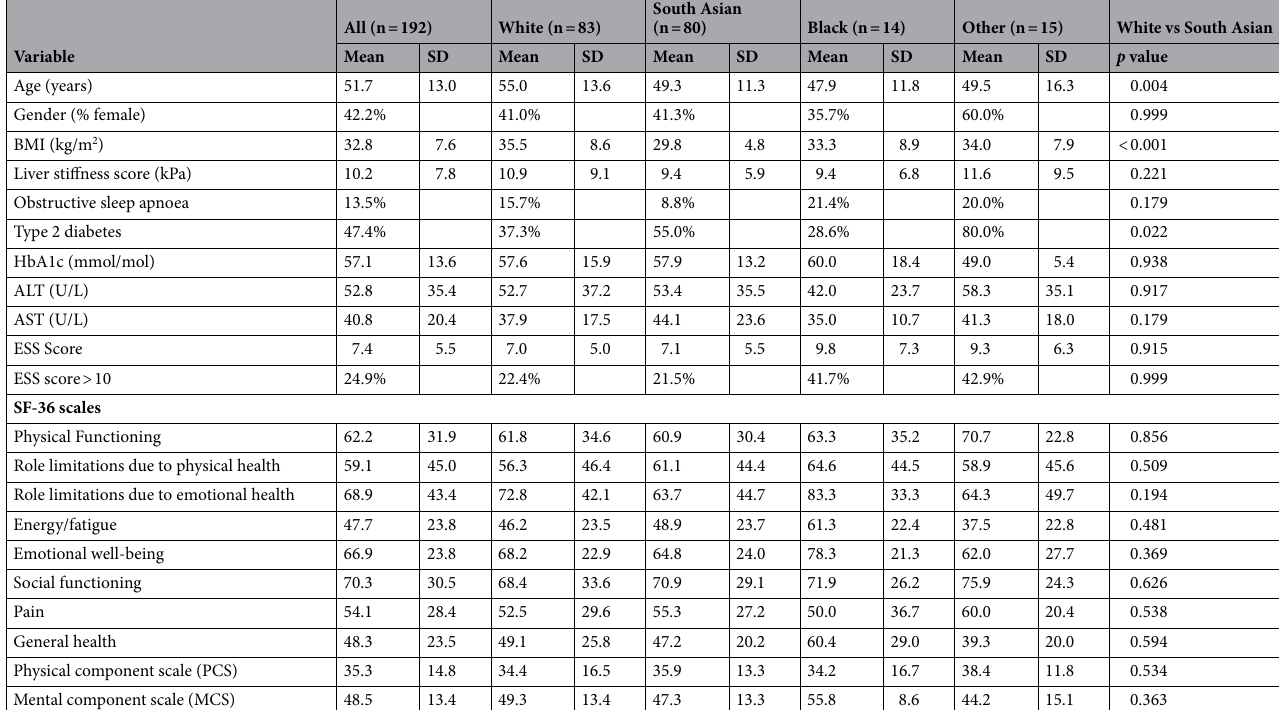
Table 1. Clinical and Quality of Life-related factors in People with NAFLD from different ethnicities. Values are mean or %. ALT alanine aminotransferase, AST aspartate aminotransferase, BMI body mass index,